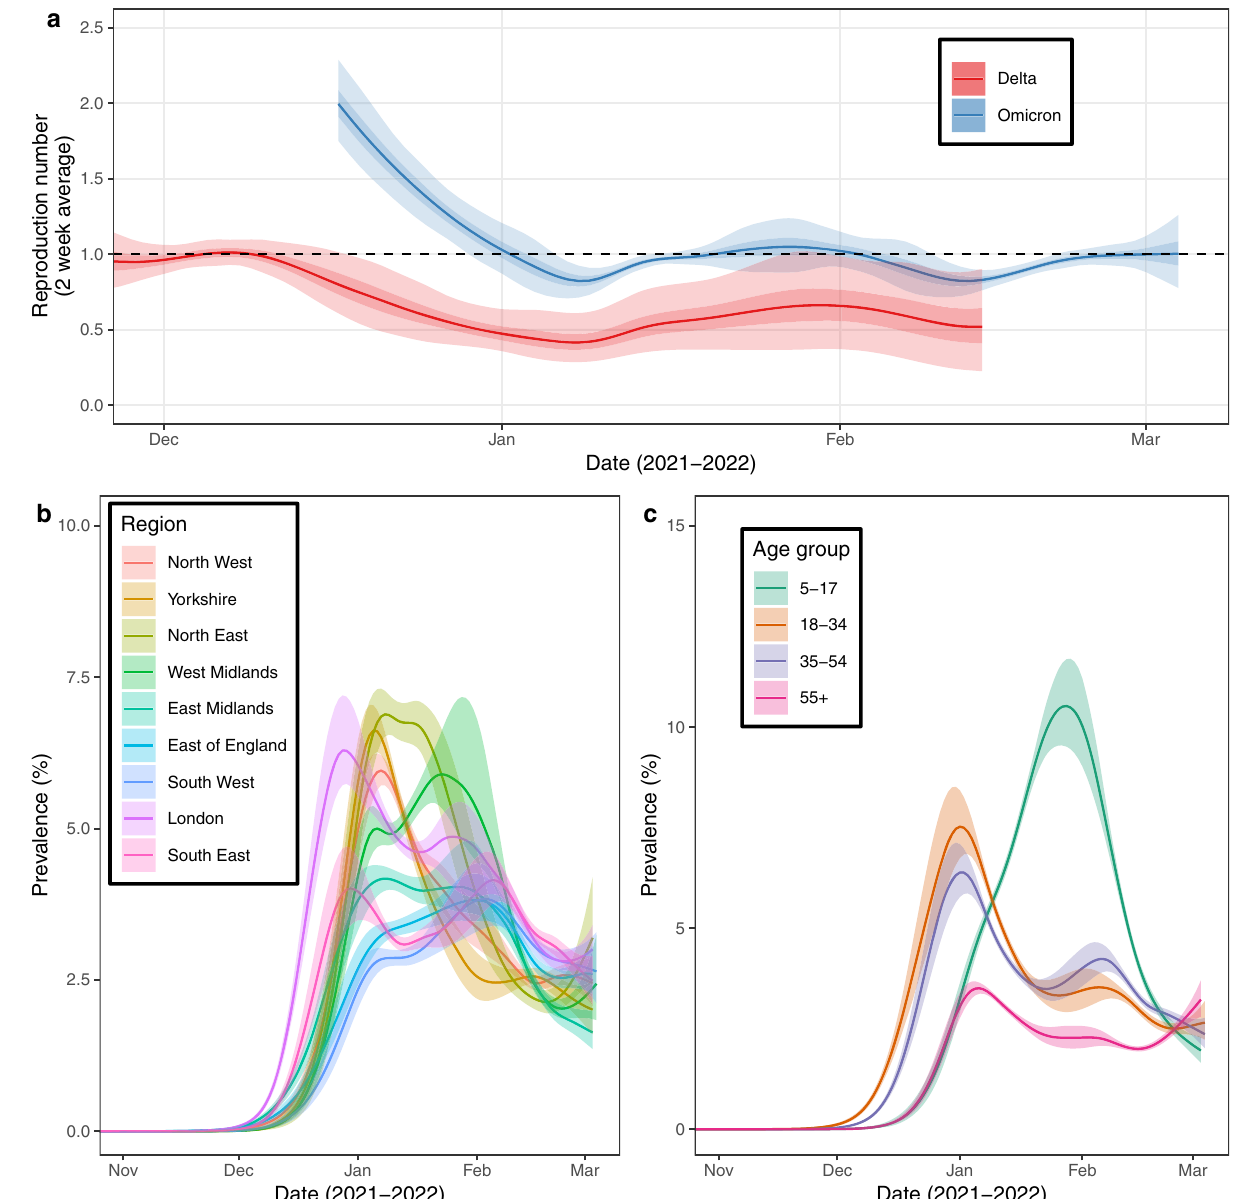
Fig. 2 | Epidemic dynamics of the Omicron wave. a Rolling two-week average (prior two weeks) Reproduction number for Omicron and Delta in England as inferredfrom the mixed-effectsBayesianP-spline model.Estimates areshownwith a central estimate (solid line) and 50% (dark shaded region) and 95% (light shaded region) credible intervals. Dashed line shows R=1 the threshold for epidemic growth. b Modelled prevalence of Omicron in each region of England, estimated using a mixed-effects Bayesian P-spline model. Estimates are shown with a central